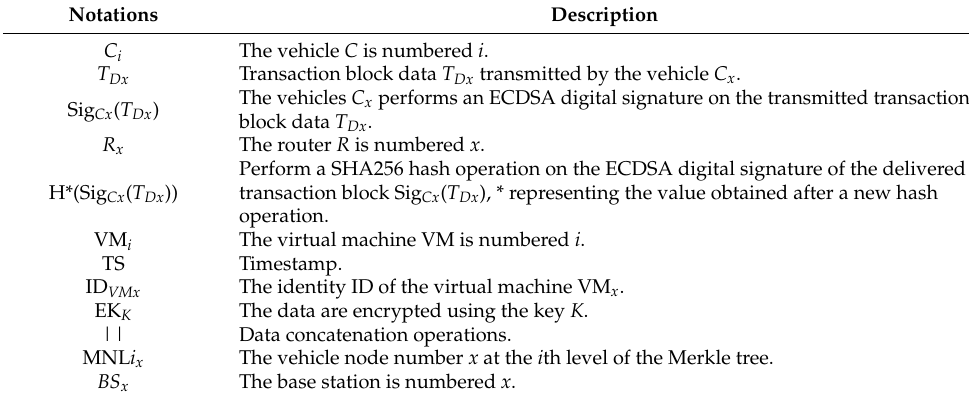
Figure 4. The routing path of the transaction block. Table 1. The usage of notation in this system.